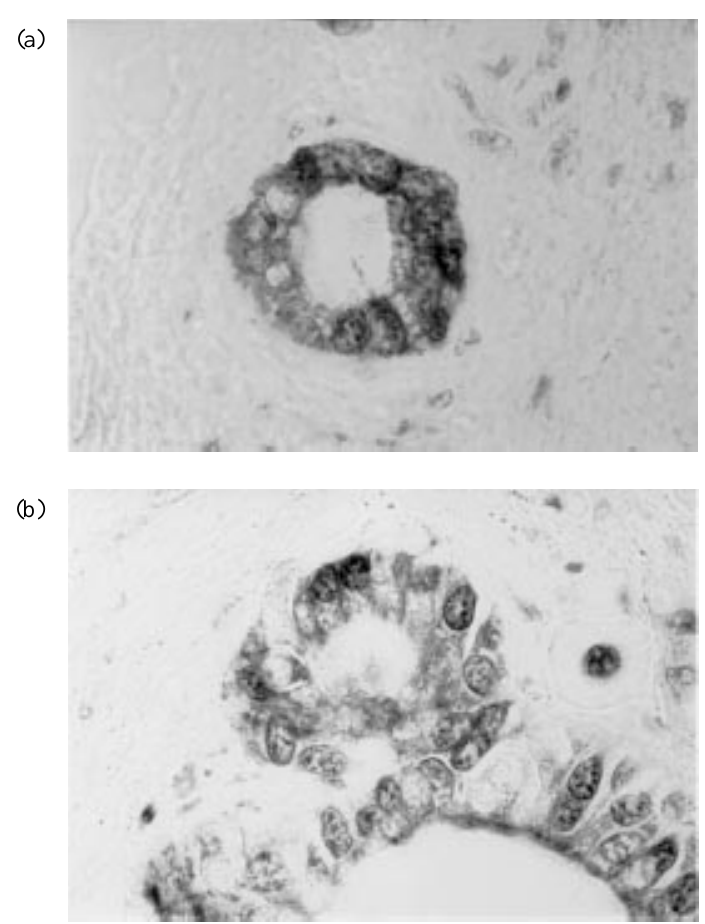
Fig. 1. (a) Bile duct epithelial cells double immunostained using LAB/LAB technique (CK 19: red, PCNA: black; original magnification 100-fold). (b) Bile duct epithelial cells double immunostained using dig–a-dig/PAP method (CK 19: brown, PCNA: black; original magnification 100-fold).